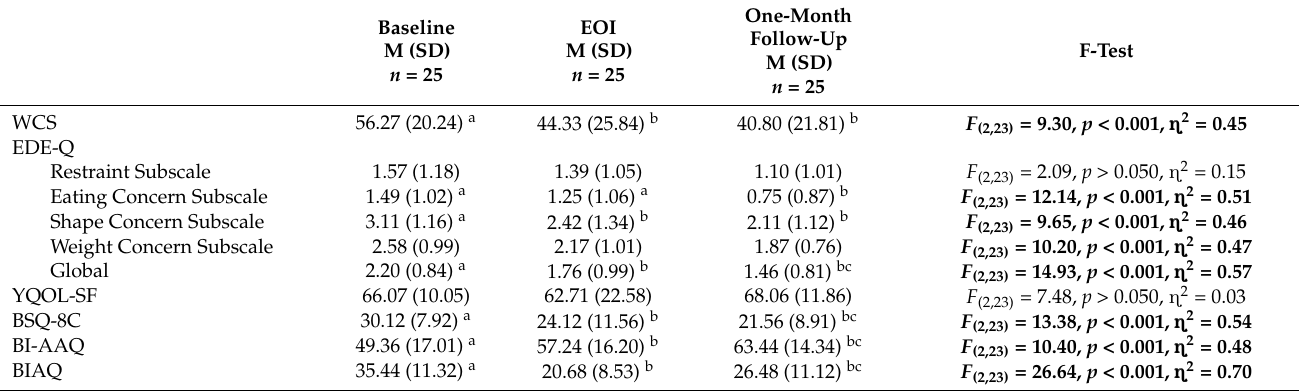
Table 2. Means and standard deviations of outcomes at baseline, EOI, and one-month follow-up for the AcceptME